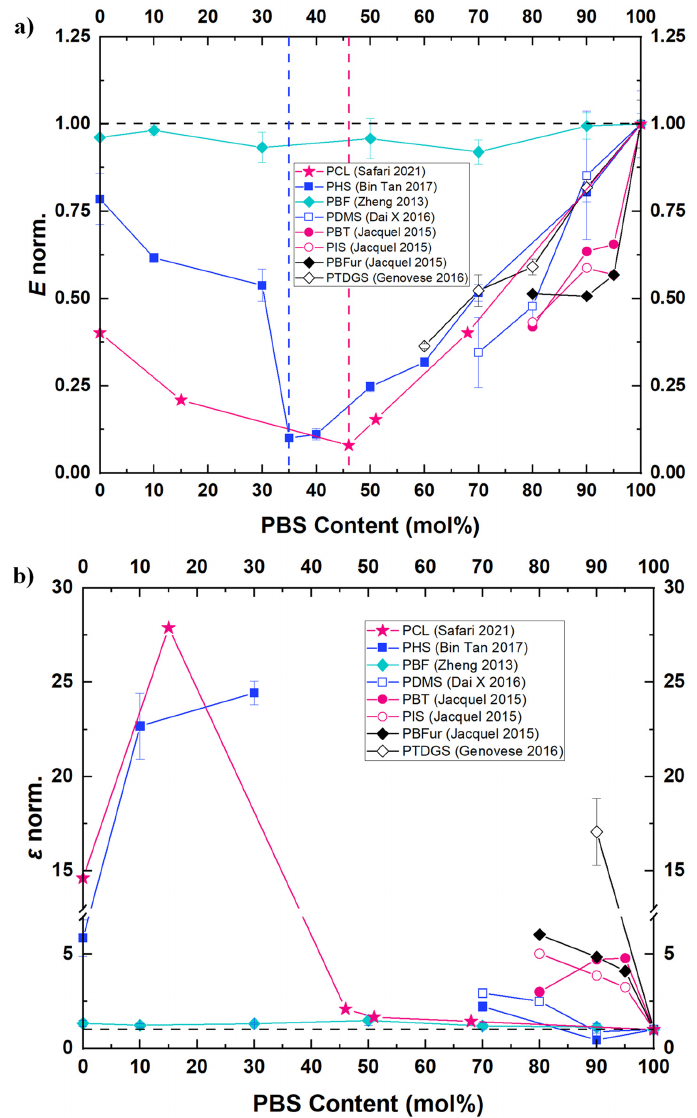
Figure 5. ( a ) Variation of the normalized elastic moduli ( E ) with PBS composition for different copolymers and ( b ) variation of the normalized elongation at break ( ε ) with PBS composition for different copolymers. For a better comparison, the values have been normalized to those of neat PBS. Dashed colored vertical lines reflect a minimum in the elastic moduli, in agreement with the composition of the pseudo-eutectic point observed in the T m vs. the composition graph (Figure 3). Generally speaking, for the PBS homopolymer, introducing a comonomer results in a decrease in the Young´s modulus and an increase in the elongation at break values. Go-